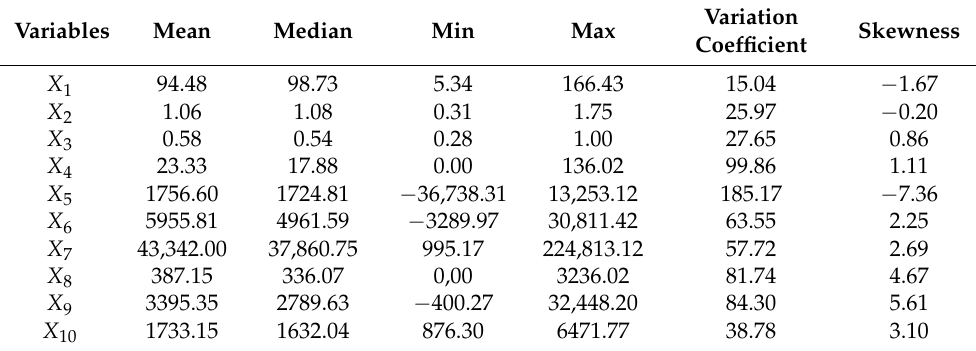
Table 5. Descriptive statistics for land productivity